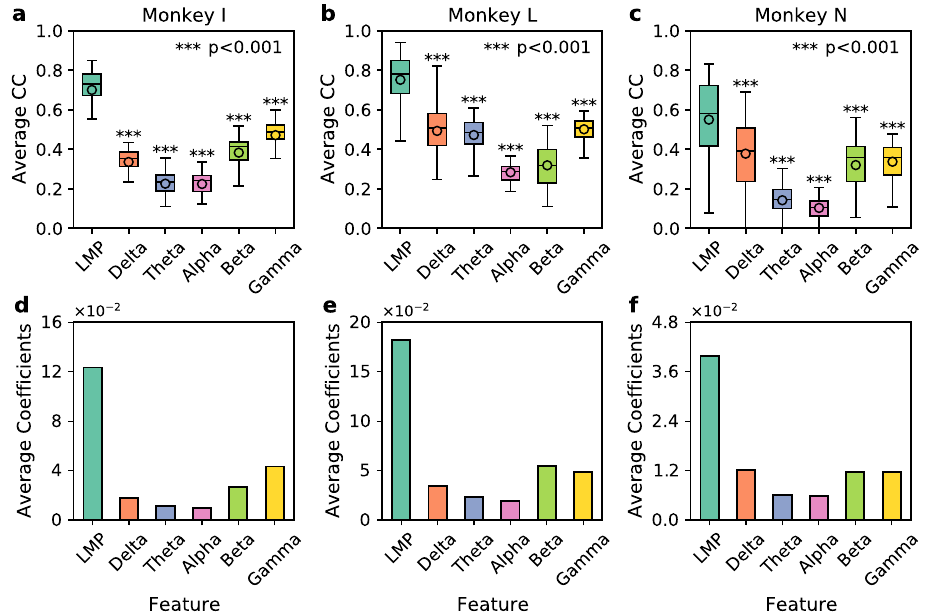
Figure 1. Comparison of ESA inference across different LFP features from three subjects. ( a – c ) Boxplot comparison of average CC across LFP features from monkey I, L, and N, respectively. Asterisks indicate LFP features whose inference performance differed significantly from that of LMP (*** p < 0.001 ). The horizontal lines and circles within the boxes indicate the median and mean, respectively. The boxes represent interquartile range (IQR) from 25th to 75th percentiles. The whisker extends 1.5 times the IQR. ( d – f ) Bar plot comparison of average coefficients (i.e. weights) across LFP features from monkey I, L, and N,